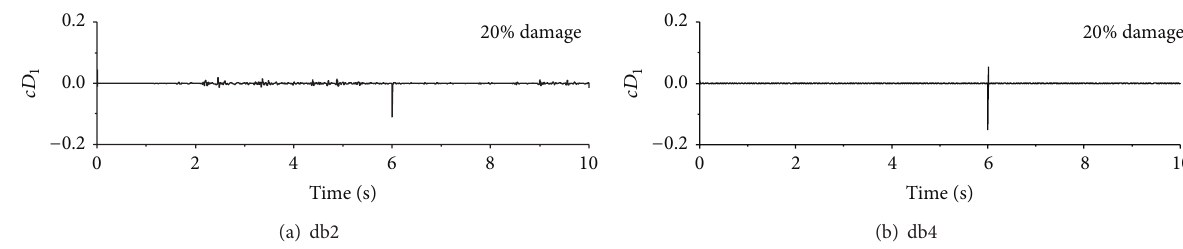
Figure 6: Level-1 detail coefficients of wavelet transform for acceleration responses under seismic excitation.